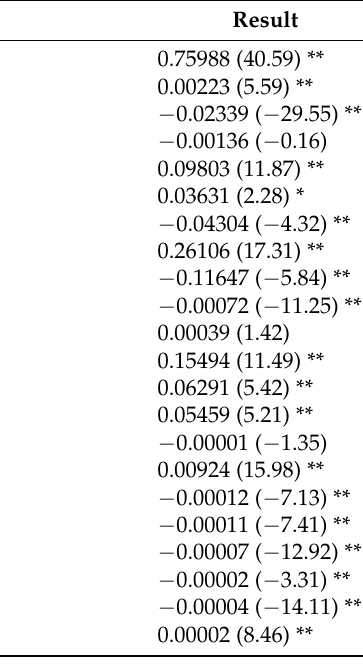
Table 6. Regression